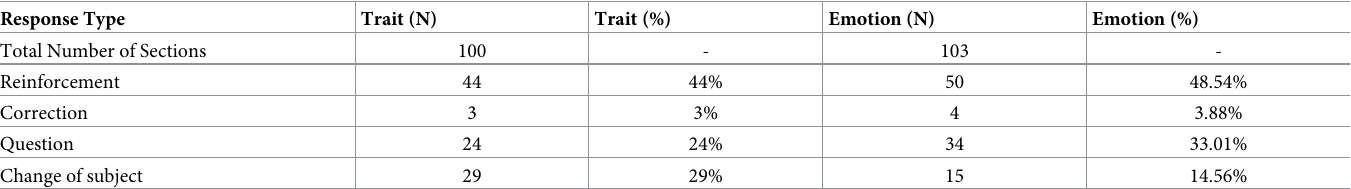
Table 4. Study 2: Frequency of parents’ responses to child trait discussion by response